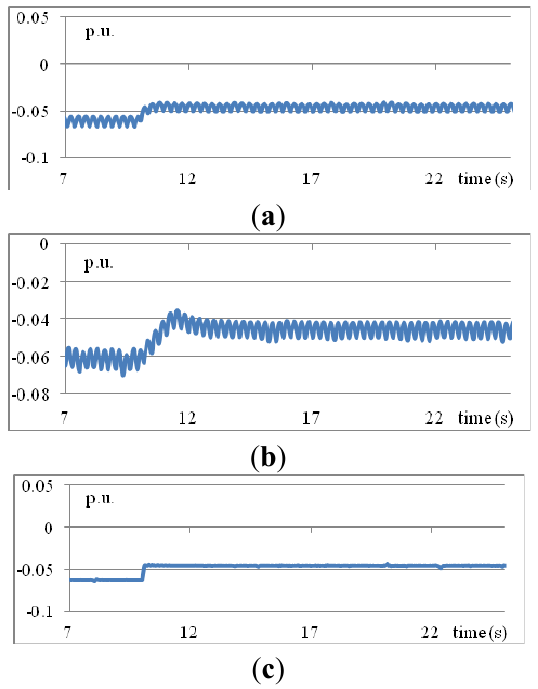
Figure 16. MVARs from STATCOM obtained using three methods: ( a ) traditional PID; ( b ) T1 fuzzy rules; and ( c ) IT2 fuzzy rules (Scenario